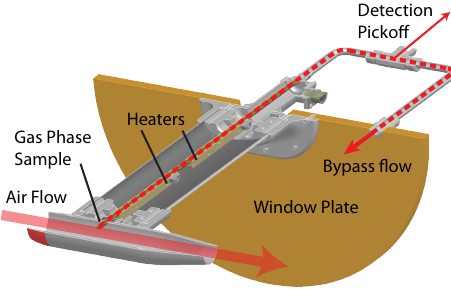
Figure 5. This diagram shows a cross-section view of the parti- cle rejection inlet mounted on a window plate. A ram air nacelle mounted on an airfoil 30cm from the plate generates ram pressure that directs the ambient air through the heated tube mounted at 90 ◦ to the flow. A small fraction (2sLm) of the heated air enters the instrument and the remainder ( ∼ 20sLm) returns to ambient. The plumbing on the cabin side of the window plate is not drawn to scale. There is 1m of tubing between the inlet and detection pick- off.